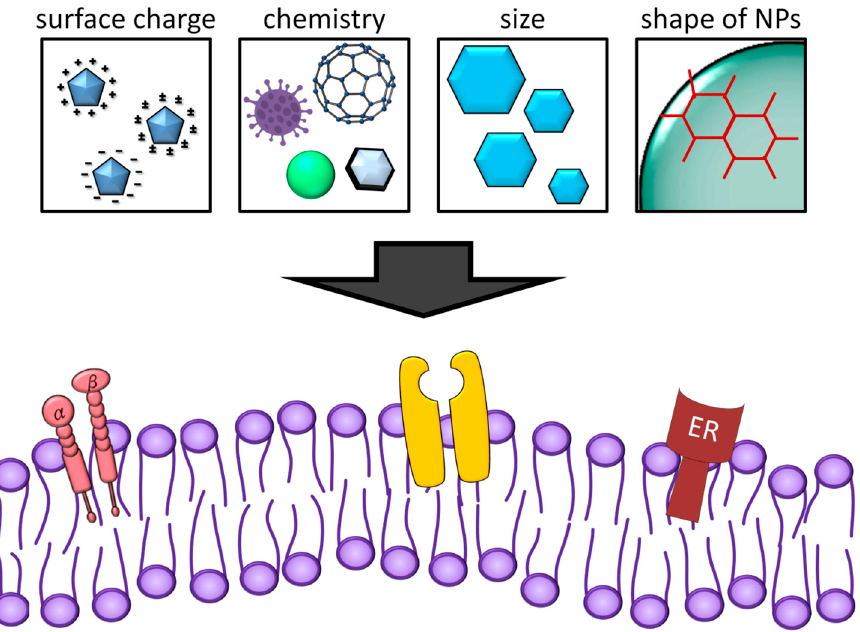
Figure 3. Factors affect cellular uptake of NPs. The NP uptake by cells is determined by their surface charge, chemistry, size, and shape.